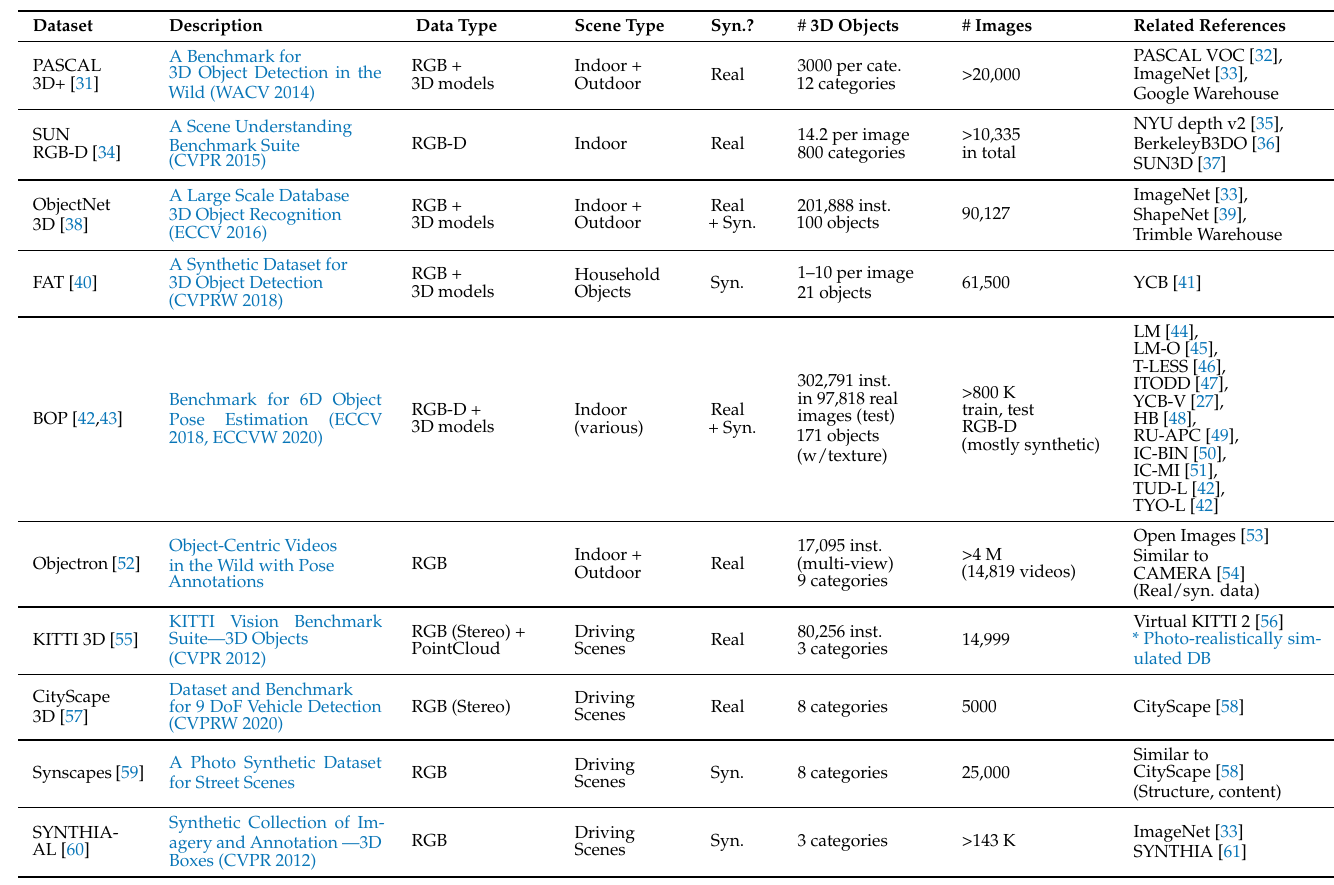
Figure 1. Overview of the 2D/3D monocular object detection methods [7–30]. Table 1. Datasets used for monocular 3D object